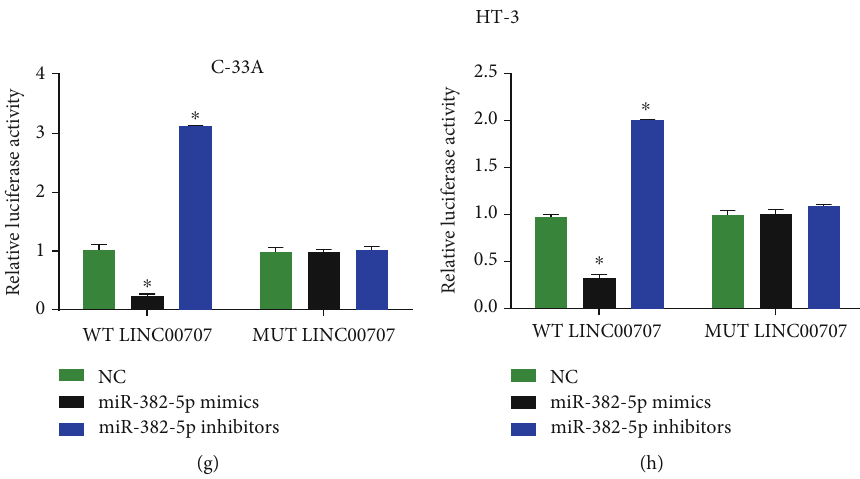
Figure 3: LINC00707 sponged miR-382-5p. (a) RT-PCR indicated miR-382-5p expression in cervical cancer. (b) miR-382-5p expression in cervical cancer cells (HT-3, HCC94, CaSki, C-33A, MS751, and HEKn cells). (c) Pearson analysis of LINC00707 and miR-382-5p in cervical cancer tissues. (d, e) miR-382-5p expression in C-33A and HT-3 cells infected with LV-LINC00707 or LINC00707 siRNA. (f) Binding sites between LINC00707 and miR-382-5p. (g, h) Luciferase activity was evaluated in C-33A and HT-3 cells cotransfected with LINC00707-WT or LINC00707-MUT reporter and miR-382-5p inhibitors or mimics. ∗ P < 0 : 05